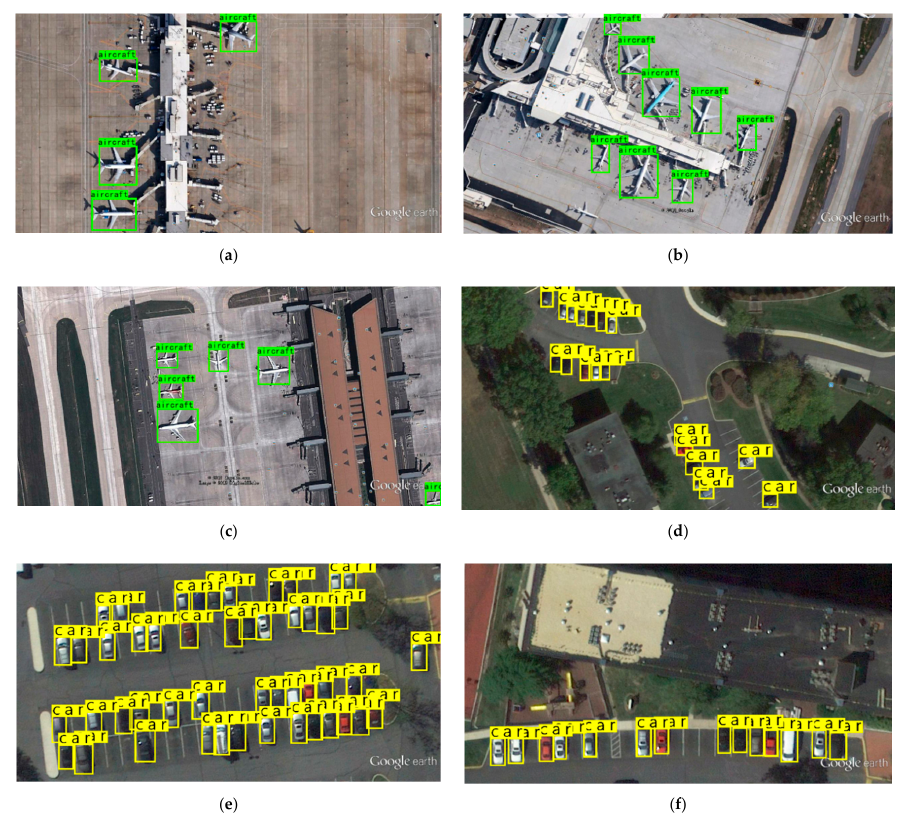
Remote Sens. 2021 , 13 , x FOR PEER REVIEW Figure 15. The detection results with the UCS-AOD dataset. Figure 15. The detection results with the UCS-AOD dataset.